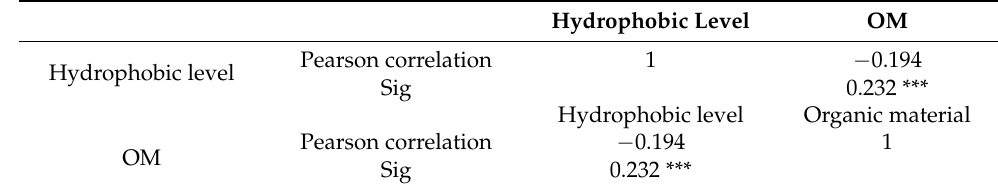
Table 3. Correlation between OM and hydrophobicity level.